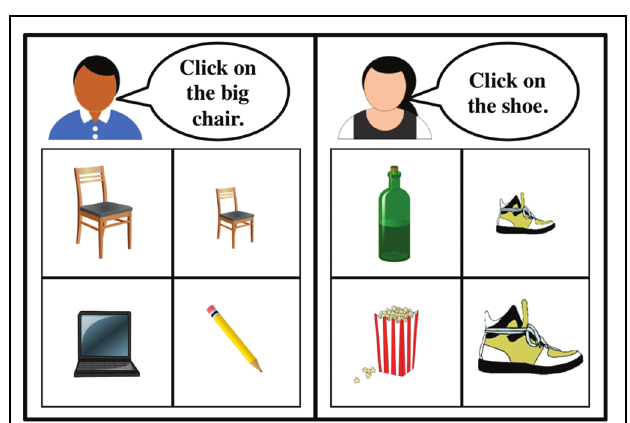
FIGURE 1 | An example of a trial (audio instructions are shown here in speech bubbles) with the modifying speaker (left) and the non-modifying speaker (right) from the Exposure Phase in Experiments 1 and 2. Participants clicked on the image in the grid to